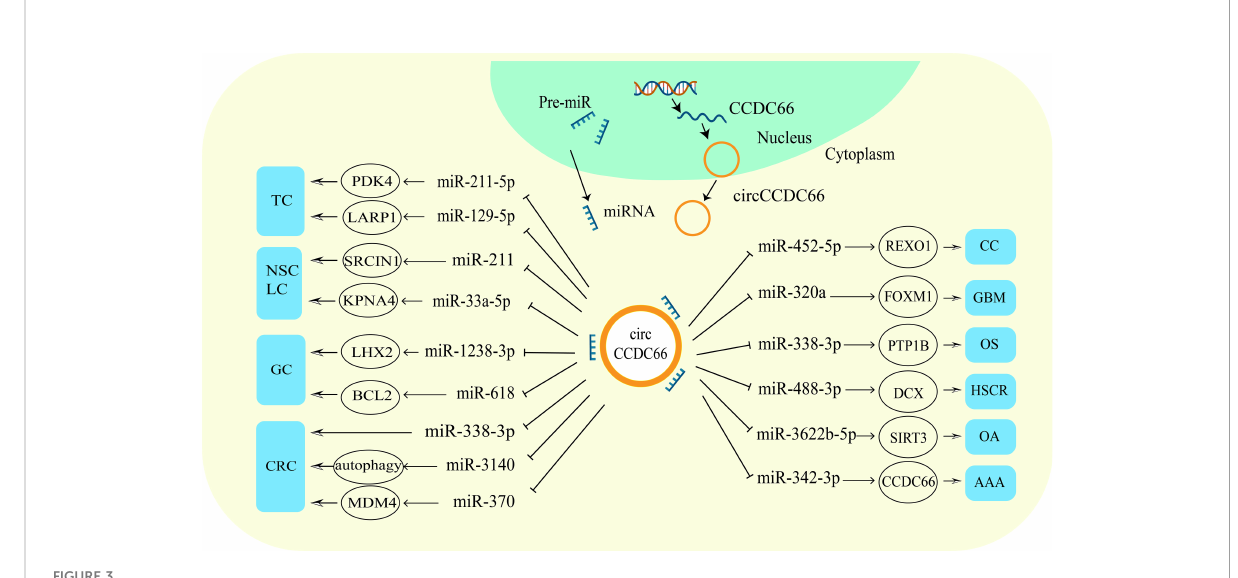
FIGURE 3 CircCCDC66 participates in various diseases through different ways. Up-regulation of circCCDC66 mediates the occurrence and development of malignant